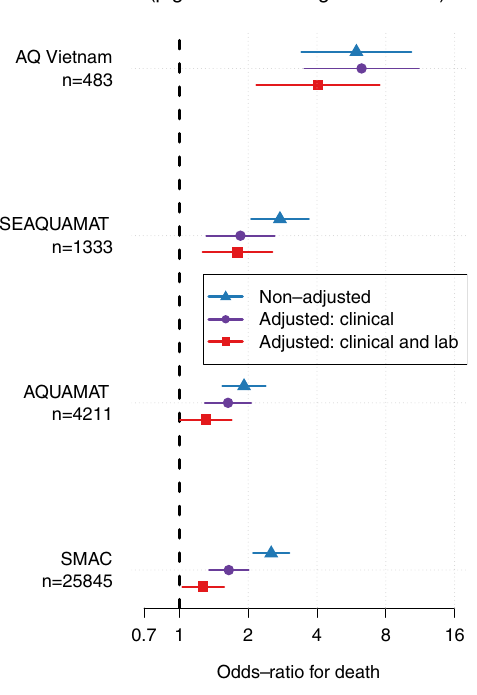
Fig. 5 | The prognostic value of intraleukocytic pigment cell counts in severe falciparummalariawithandwithoutadjustmentforknownprognosticclinical and laboratory variables (clinical: coma and acidosis; laboratory: hypogly- caemia and either venous lactate for AQ Vietnam and SMAC or blood urea nitrogen for SEAQUAMAT and AQUAMAT). Panel a : PMNs (polymorphonuclear